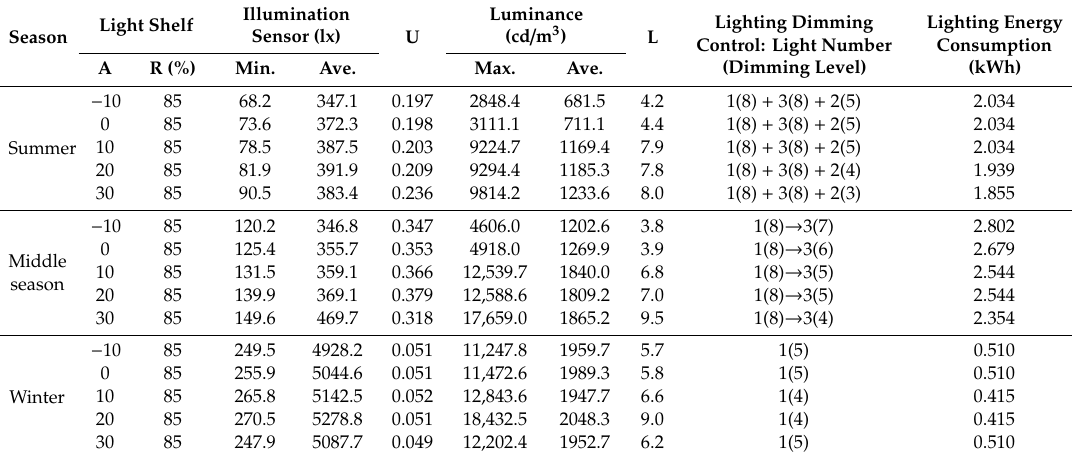
Table 7. Performance evaluation results of Case 1 and Case 2: analysis of uniformity, glare, and lighting energy consumption.